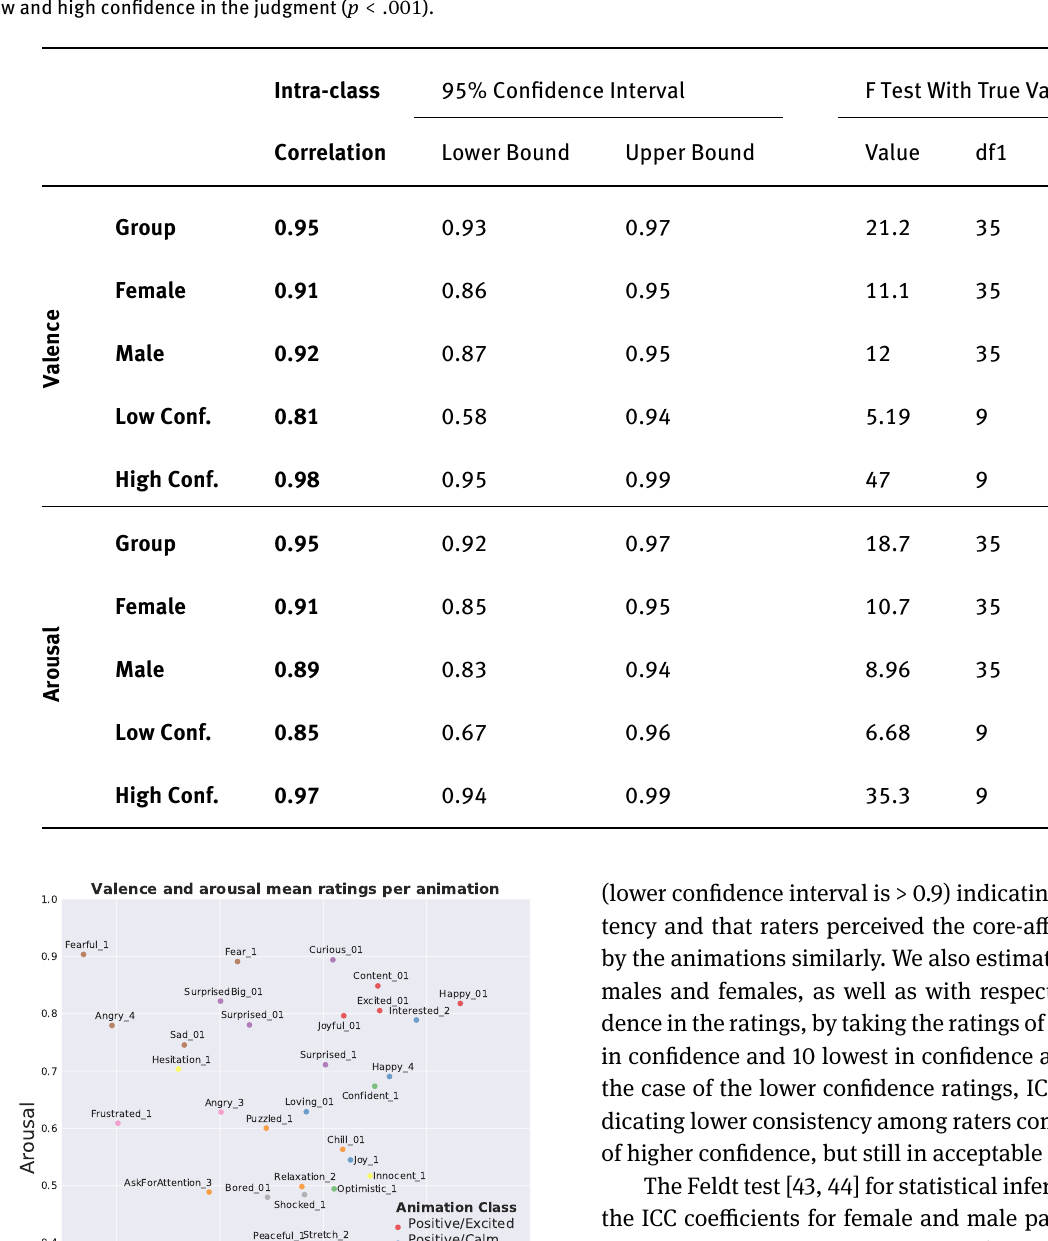
Table 3: Intra-class correlation coeflcients indicate the inter-rater reliability for: a) the whole group, b) female and male participants, and c) low and high confidence in the judgment ( p < .001 ).